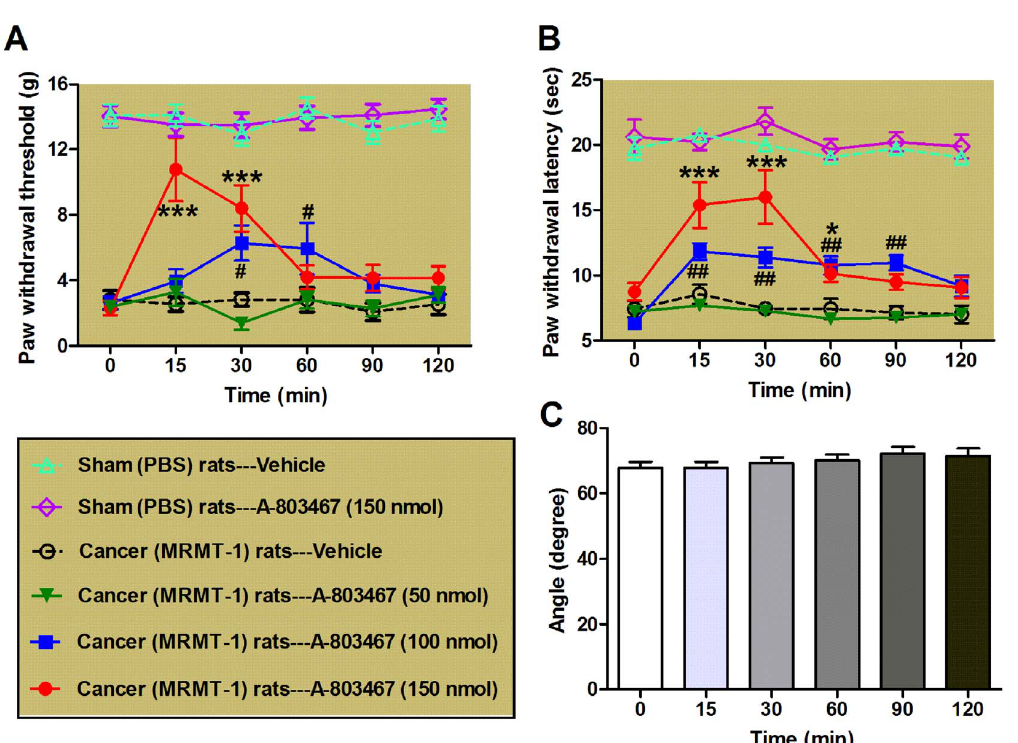
Fig. 4. Effects of A-803467, a selective blocker of Nav1.8, on bone cancer-induced mechanical allodynia and thermal hyperalgesia in rats. (A, B): Effects of A-803467 (at 50, 100 and 150 nmol) on mechanical (A) and thermal (B) pain behaviors in rats evaluated on day 14 after the inoculation of MRMT-1 tumor cells or PBS. Note that A-803467 remarkably restores the tumor cells-induced reduction of PWTand PWL in cancer model rats but has no significant effect on the PWL and PWT in PBS inoculated sham rats. */ # P , 0.05, **/ ## P , 0.01, *** P , 0.001, compared to vehicle/cancer (MRMT-1) rats group, two-way ANOVA, n 5 6–9/group. (C): Inclined-plate test. Note that intrathecal administration of A-803467 at the maximal dose of 150 nmol has no significant effect on the locomotor function of rats. P . 0.05, one-way ANOVA, n 5